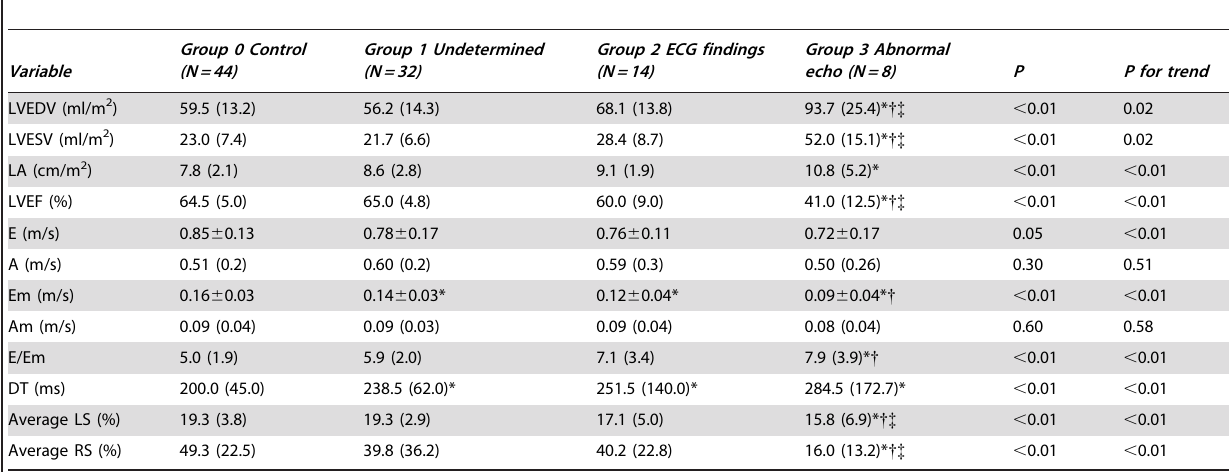
Table 2. Echocardiographic parameters of control individuals and patients in the undetermined and cardiac forms.